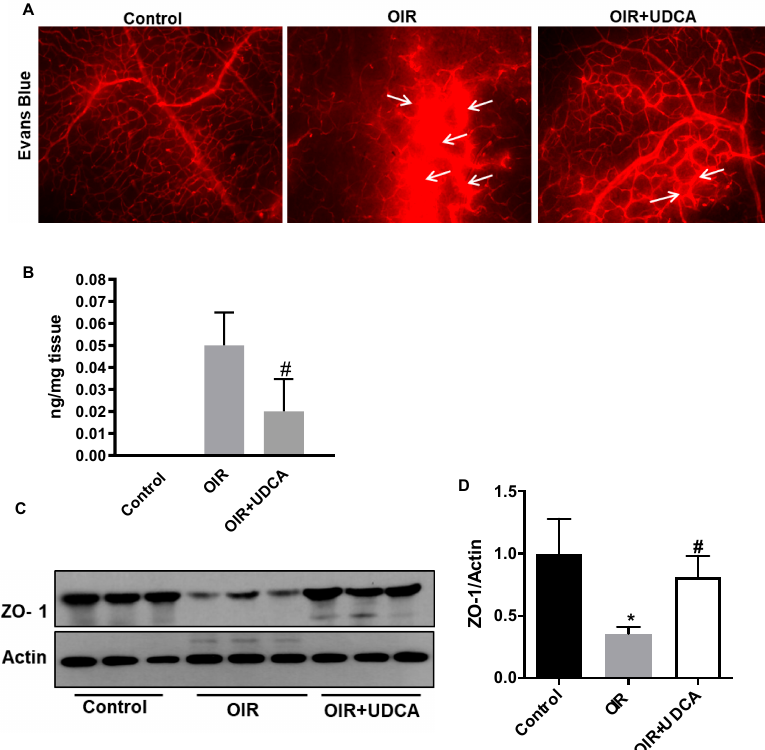
Figure 4. UDCA preserves blood–retinal barrier in OIR mice. ( A ) Evans blue (EB) dye extravasation (white arrows) assessed at P17, in control mice (room air), OIR mice, and OIR+UDCA mice (treated with 50 mg / kg UDCA from P7-P17). Two hours after EB injection, eyes were collected to prepare flat mounts and examined using a fluorescence microscope. ( B ) In a separate set of experiments, EB-injected mice were perfused with phosphate-bu ff ered saline (PBS), and the residual dye in the retina was quantified following formamide extraction. ( C ) Representative image of zonula occludin-1 (ZO-1) immunoblotting from the di ff erent treatment groups. ( D ) Densitometry results showing changes in ZO-1 protein expression normalized to the loading control actin. Values are mean ± S.D. ( n = 6 retinas per group). * p < 0.05 vs. control and # p < 0.05 vs. OIR.